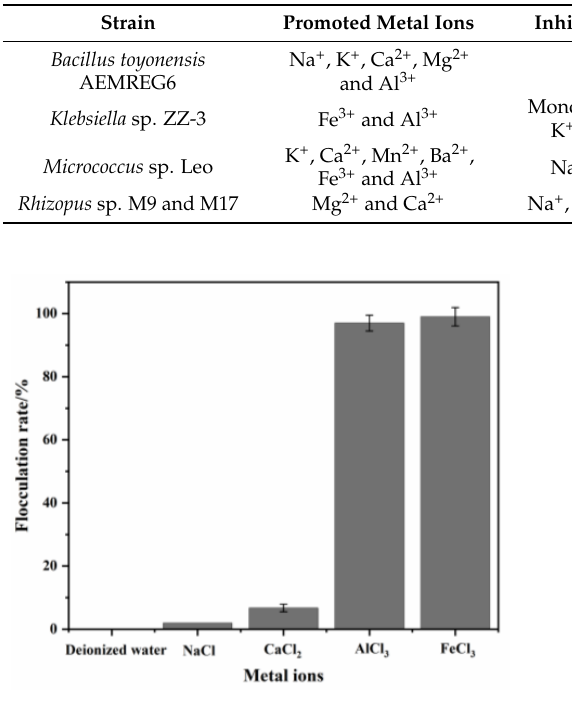
Table 2. Effect of metal ion valency on the flocculating activity of various biological flocculants. Strain Promoted Metal Ions Inhibited Metal Ions Optimal FR Ref.